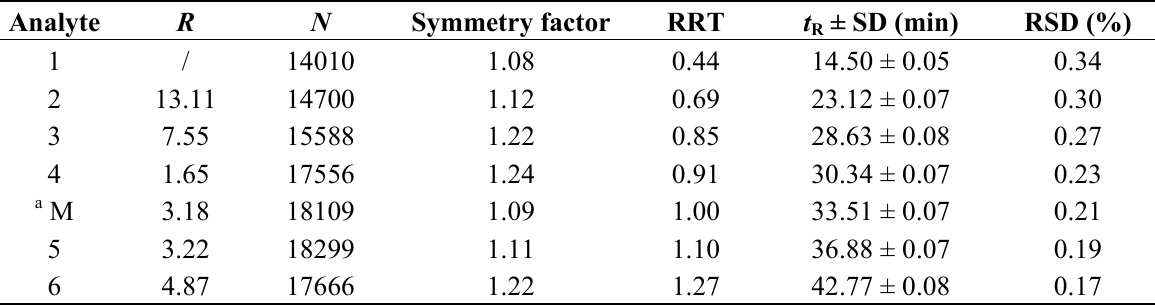
Table 1. System suitability parameters.